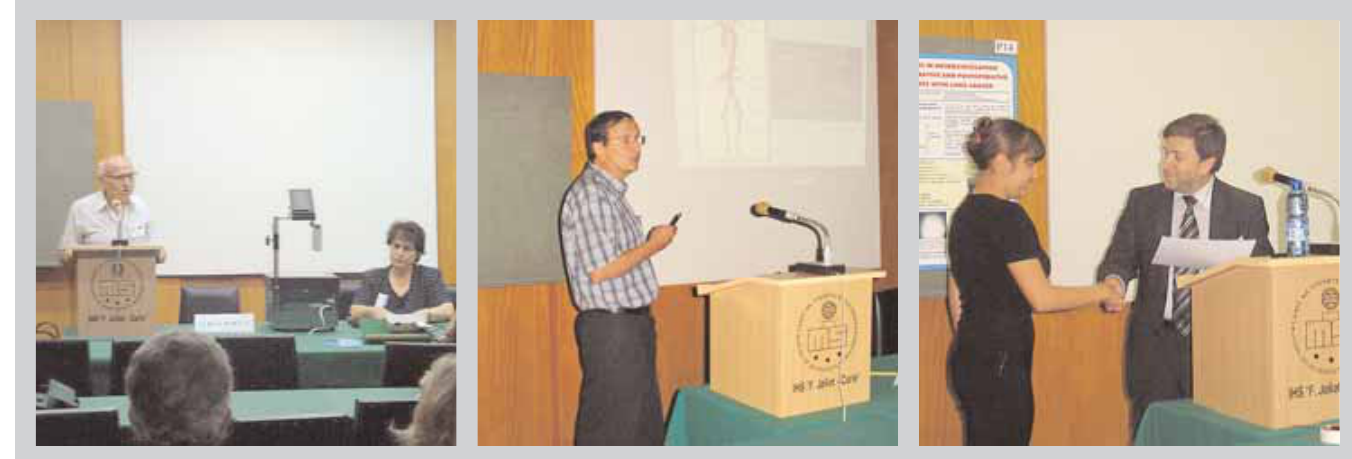
Figure 2 (middle): Gerard Nash from the Med- ical School to the University of Birmingham in UK deliv- ered lectures on the influ- ence of local haemodynam- ics and blood rheology on the recruitment of leuko- cytes to the wall of blood vessels. Figure 3: E.S. Drozd, a student from the Belarusian State Uni- versity in Minsk, Belarus was awarded by a diploma for best young scientific work by E. Manoach (Direc- tor of the Institute of Mechanics and Biomechan- ics) and N. Antonova (Presi- dent of the Bulgarian Soci- ety of